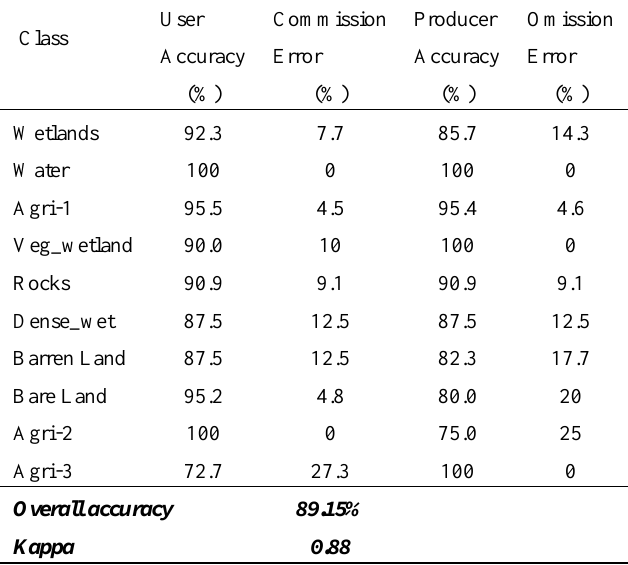
Table 2. Classification accuracy assessment